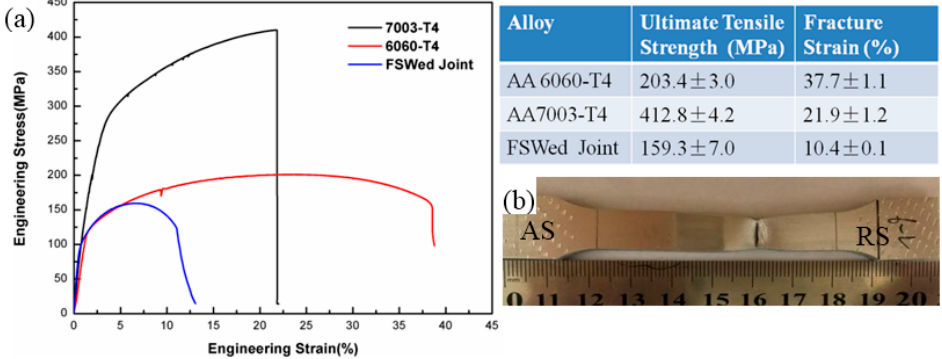
Figure 10. The uniaxial tensile curve and sample.